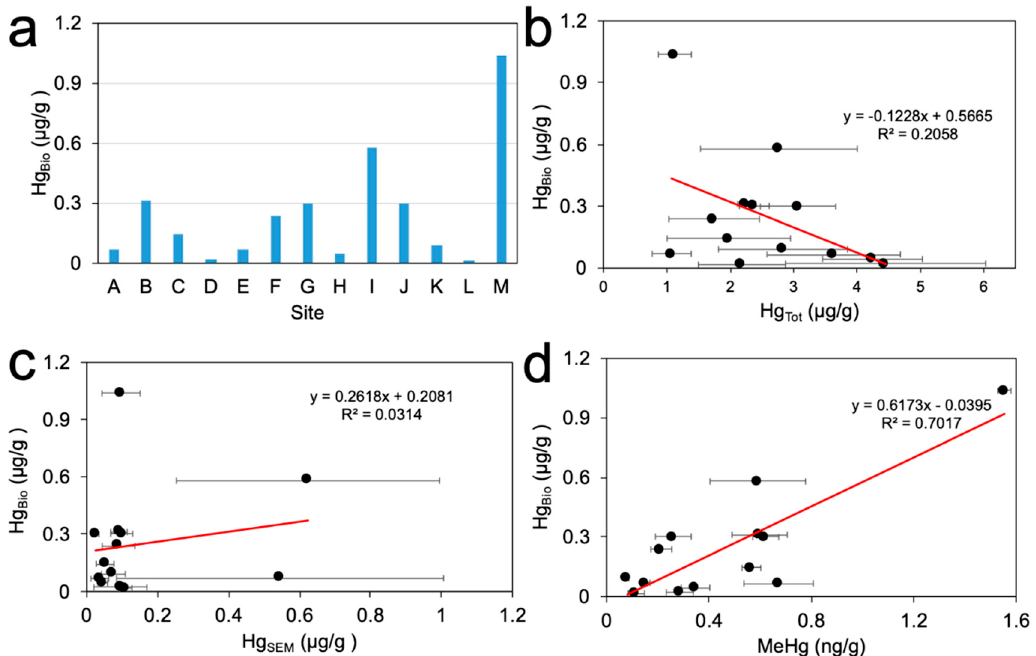
Figure 2. ( a ) Bio-accumulated mercury concentration in the benthic organisms of each sediment, and correlations between bio-accumulated mercury and ( b ) total mercury, ( c ) simultaneously extracted mercury, and ( d ) methylmercury in each sediment.